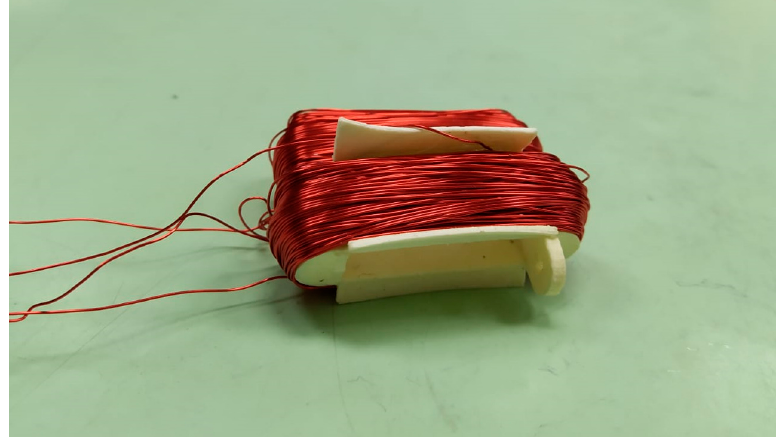
Figure 8. Fluid core double coil sensor used in the experimental setup.